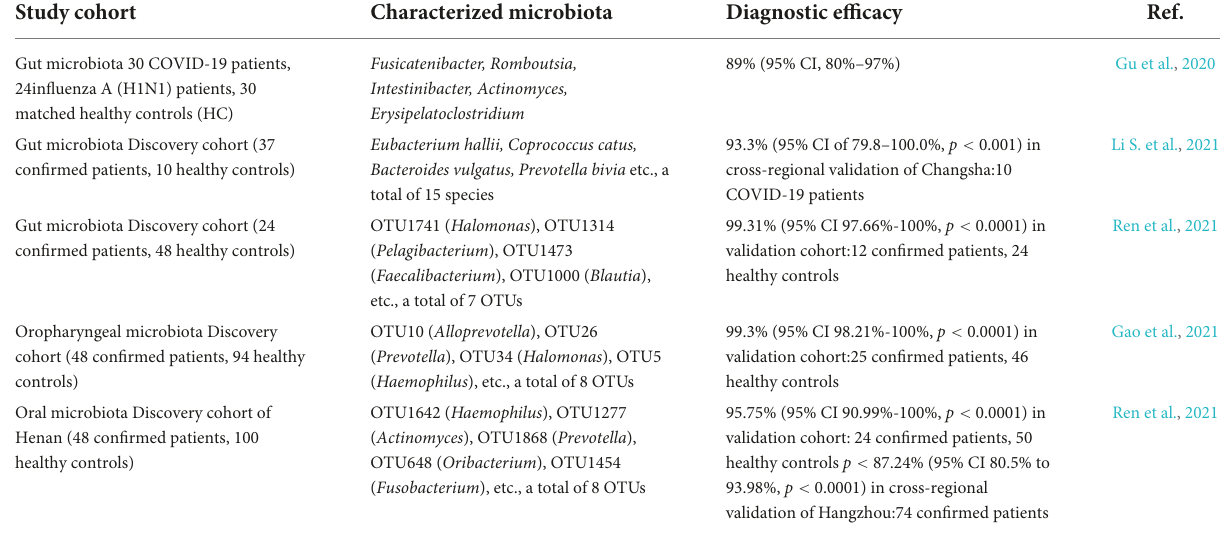
TABLE 2 Microbial markers as a diagnostic model for